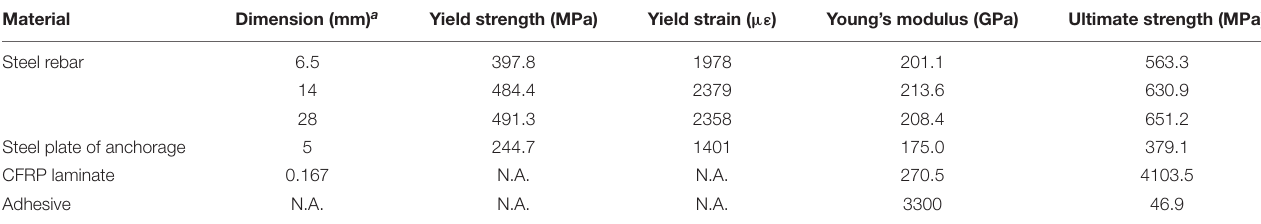
TABLE 2 | Material